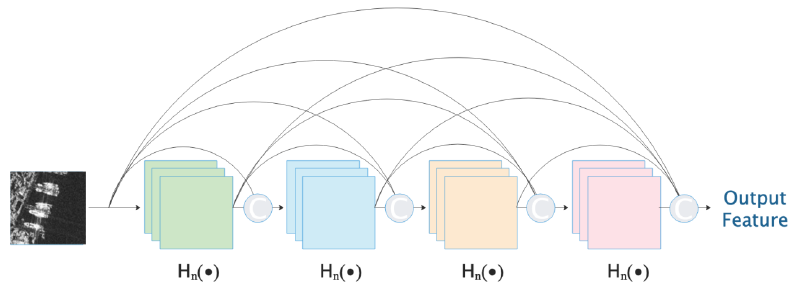
Figure 3. Description of dense feature reuse (DFR)